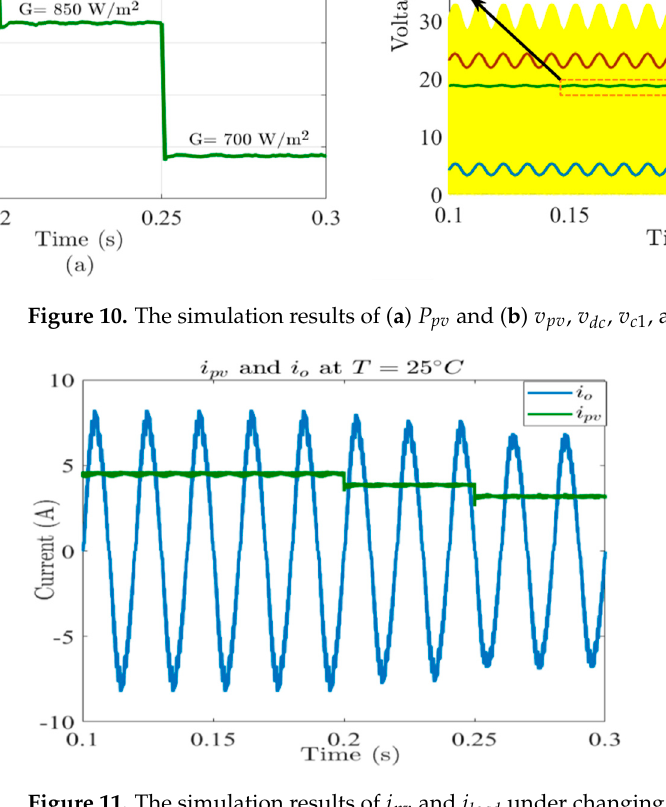
Table 3. Simulation results of the SMC-PCPV.